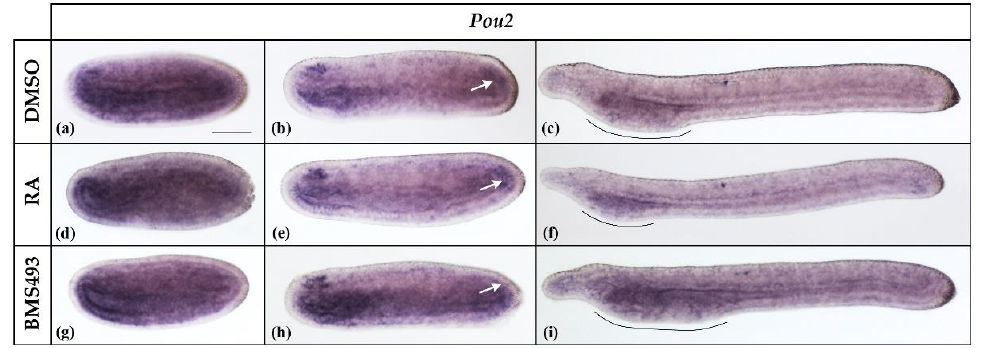
Figure 2. Expression of Pou2 in N2-, N4-, and T1-stage Branchiostoma lanceolatum embryos. ( a – c ) Control embryos (DMSO-treated). ( d – f ) Retinoic acid (RA) signaling activation with all- trans retinoic acid (RA). ( g – i ) RA signaling inhibition with the inverse agonist BMS493. Pou2 expression is widespread in the embryo and slightly more conspicuous in the pharyngeal endoderm and anterior neural plate in N2 neurulae ( a , d , g ). At the N4 stage, expression is restricted to the endoderm, the anterior nerve cord, and the tail bud region (white arrows) ( b , e , h ). Pou2 expression is subsequently downregulated and becomes restricted, at the T1 stage, to the pharyngeal region, with the extent of the Pou2 signal depending on the overall size of the pharynx (pharynx extent delimited by black lines) ( c , f , i ). Whole mount embryos are shown in lateral views; the anterior is to the left. The scale bar in ( a ) is 50 μm and is valid fo r all panels.